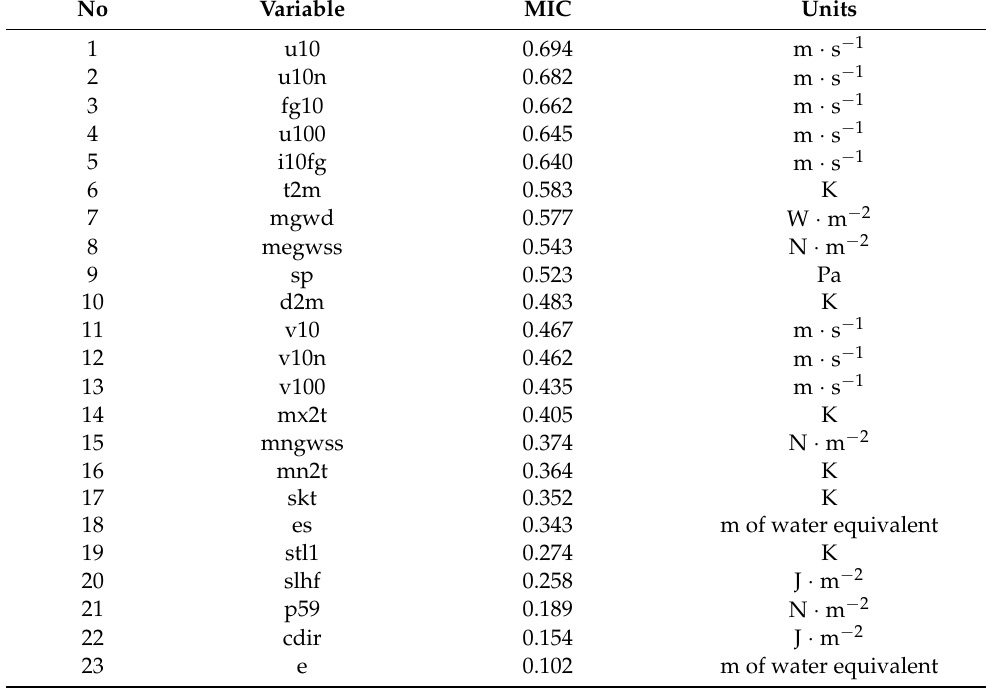
Table 2. The MIC value of wind power output and meteorological factors in Yunnan.